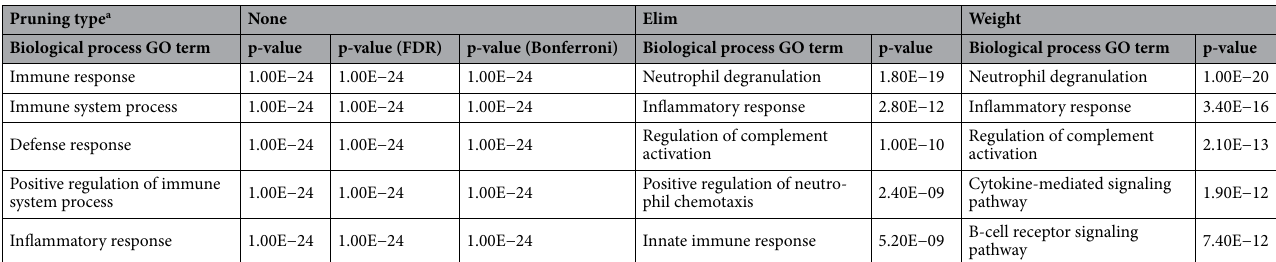
Table 3. Top significant biological processes identified by RNA sequencing analysis of human VAT. a elim and weight pruning methods were used to assess the enrichment of GO terms by considering the structure of the gene ontology. The elim pruning eliminated the genes mapped to a significant GO term from more general (higher level) GO terms, while the weight pruning assigned weight to each gene annotated to a GO term based on the scores of neighboring GO terms. The p-value GO terms was corrected for multiple comparisons using FDR and Bonferroni